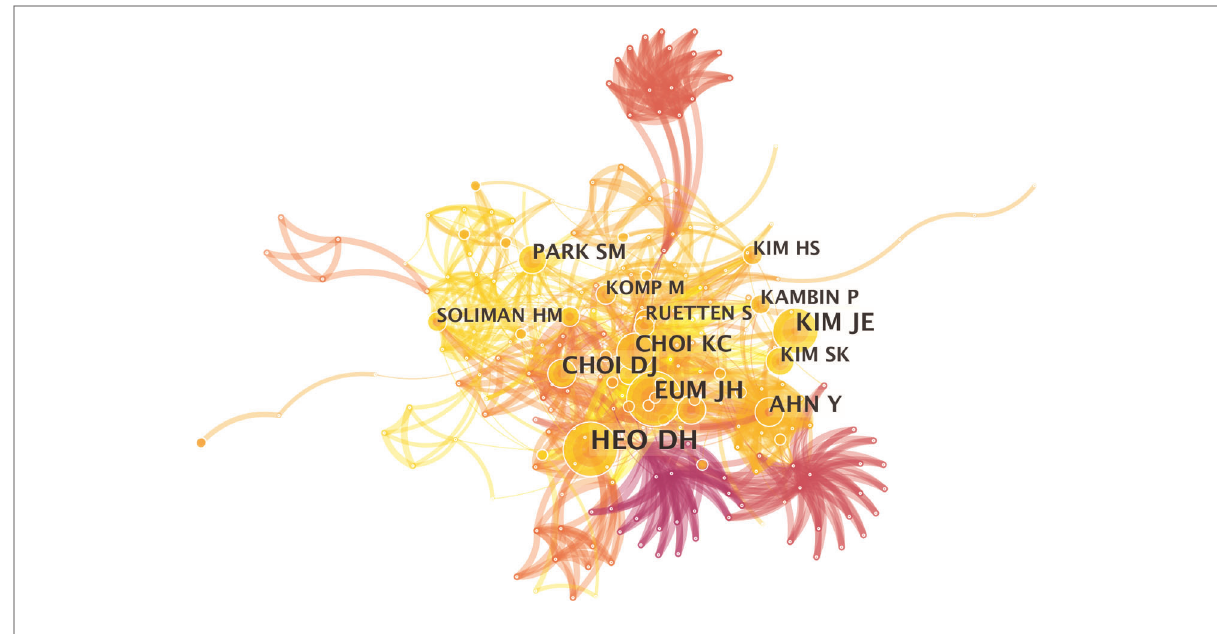
FIGURE 4 Co-operation network of the cited authors.